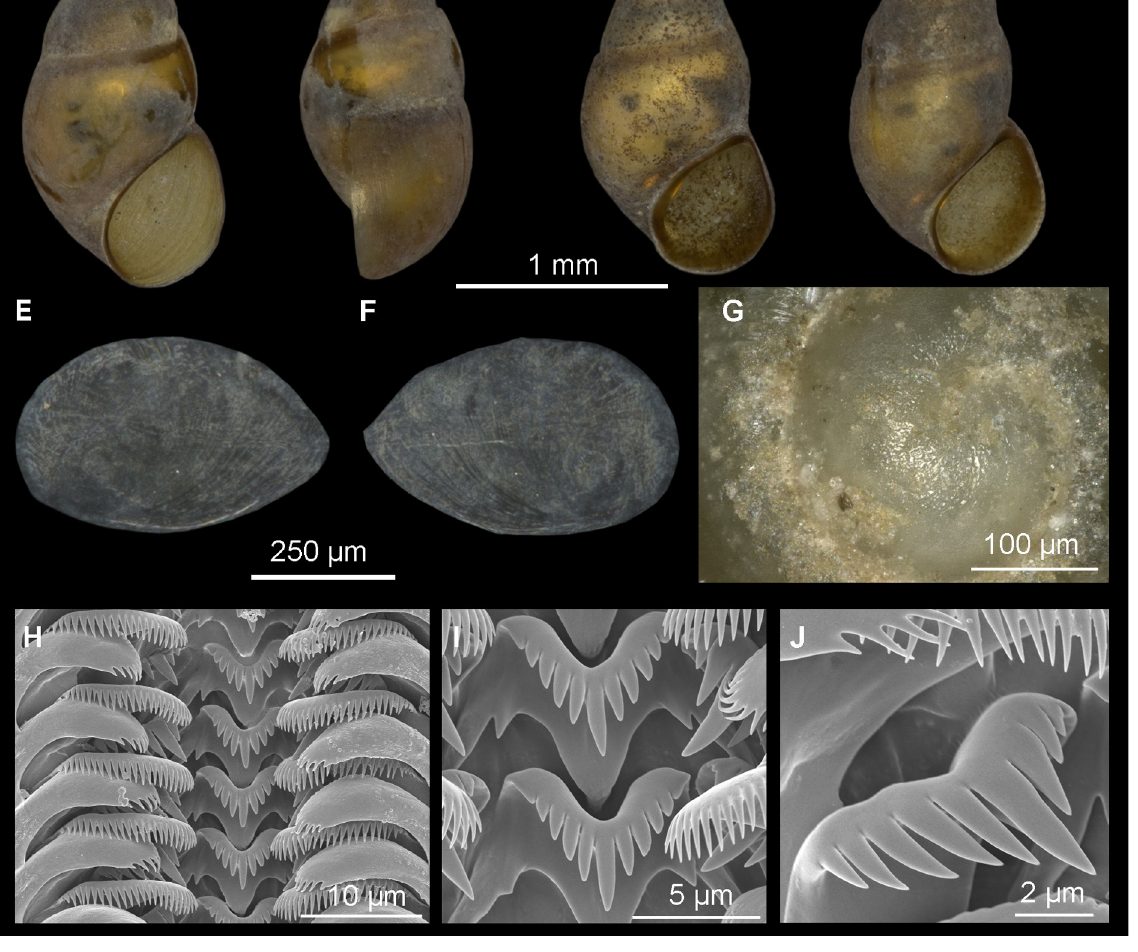
Fig. 3. Shells, opercula and radulae, Belgrandiellopsis chorfensis gen. et sp. nov. A–D . Shells. A–B . Holotype, MNCN 15.05/200097H. C–D . Paratypes, MNCN 15.05/200097P. E–F . Operculum (E = inner side; F = outer side). G . Detailed microsculpture of protoconch. H–J . Radulae. H . Portion of radula ribbon. I . Central radular teeth. J . Lateral